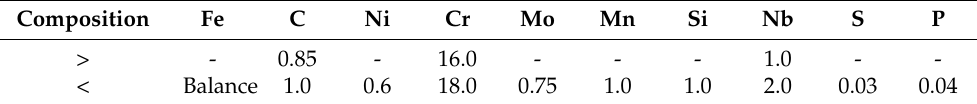
Table 1. Typical composition of PolyMIM 440C stainless steel (as sintered in % by weight).